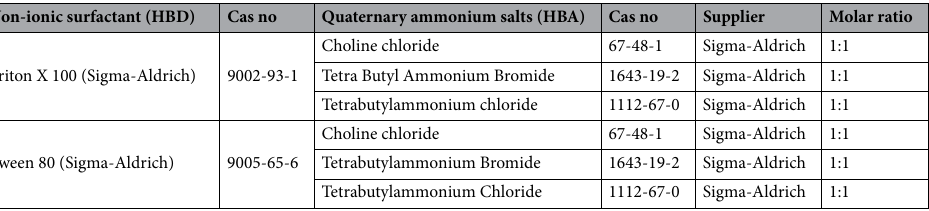
Table 1. Various non-ionic surfactants acting as HBD and quaternary ammonium salts acting as HBA involved in formation of six SDES and their corresponding molar ratio for synthesis. Relative uncertainty for the molar mass of HBA and HBD is u r (X) =